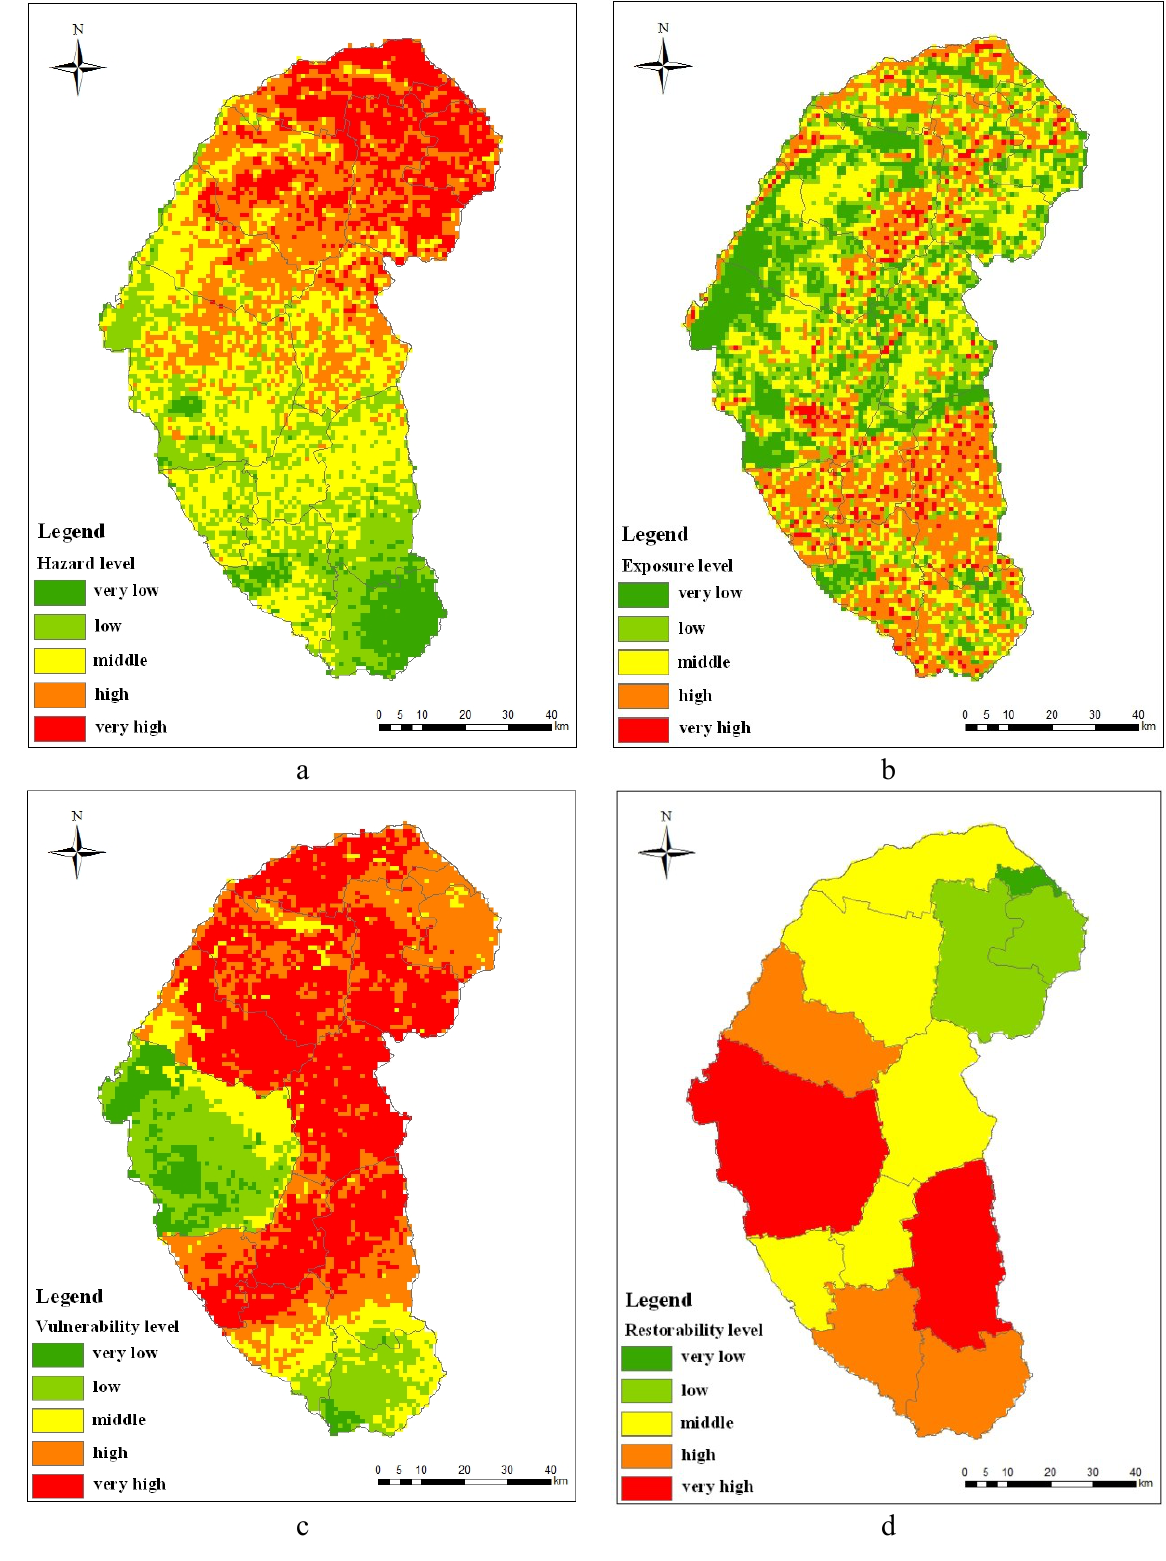
Figure 5. ( a ) Level zoning map of desertification disaster risk hazard. ( b ) Level zoning map of desertification disaster risk exposure. ( c ) Level zoning map of desertification disaster risk vulnerability. ( d ) Level zoning map of desertification disaster risk